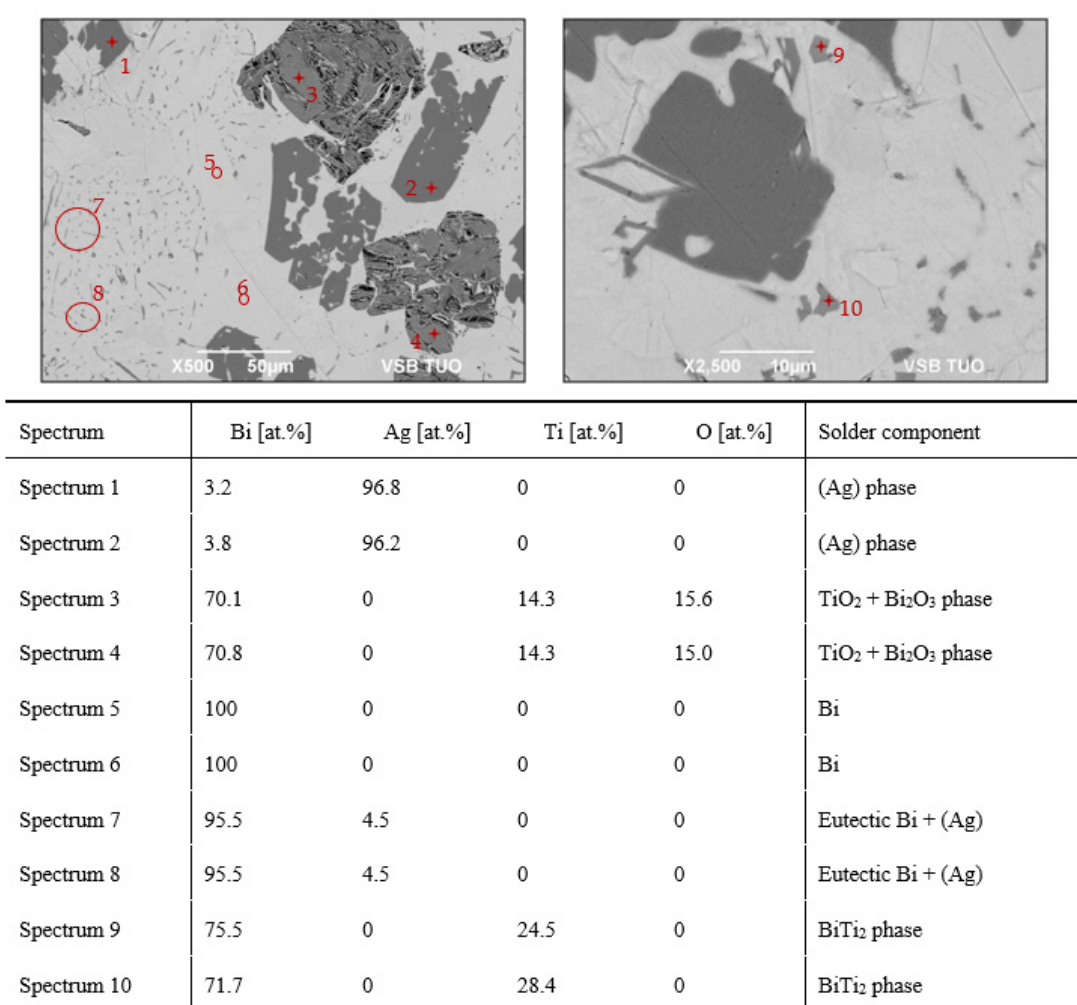
Figure 7. Microstructure of Bi11Ag1.5Ti solder after etching viewed by the optical microscope.